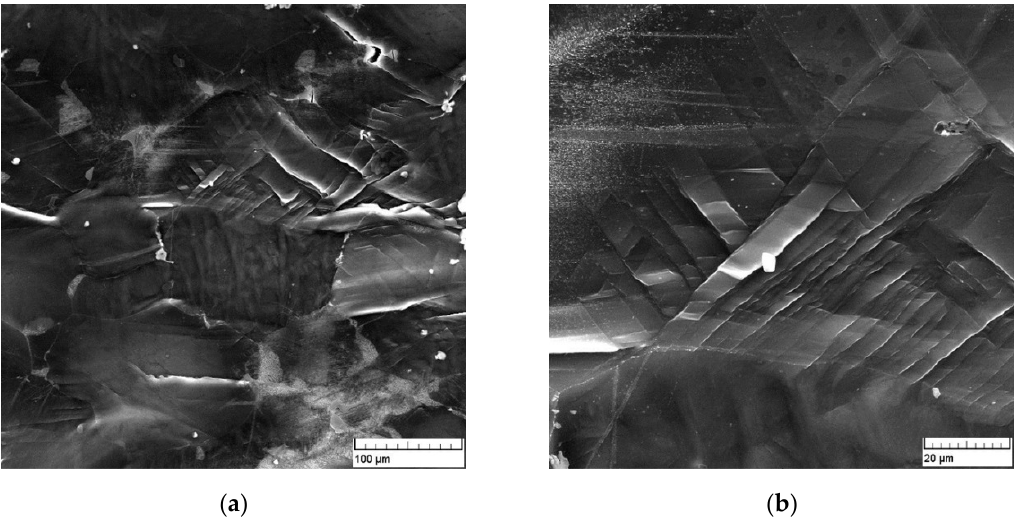
Figure 15. Deformation traces on the surface of the AZ61 alloy. ( a ) Massive deformation bands in particular grains. ( b ) Detail of strain bands.